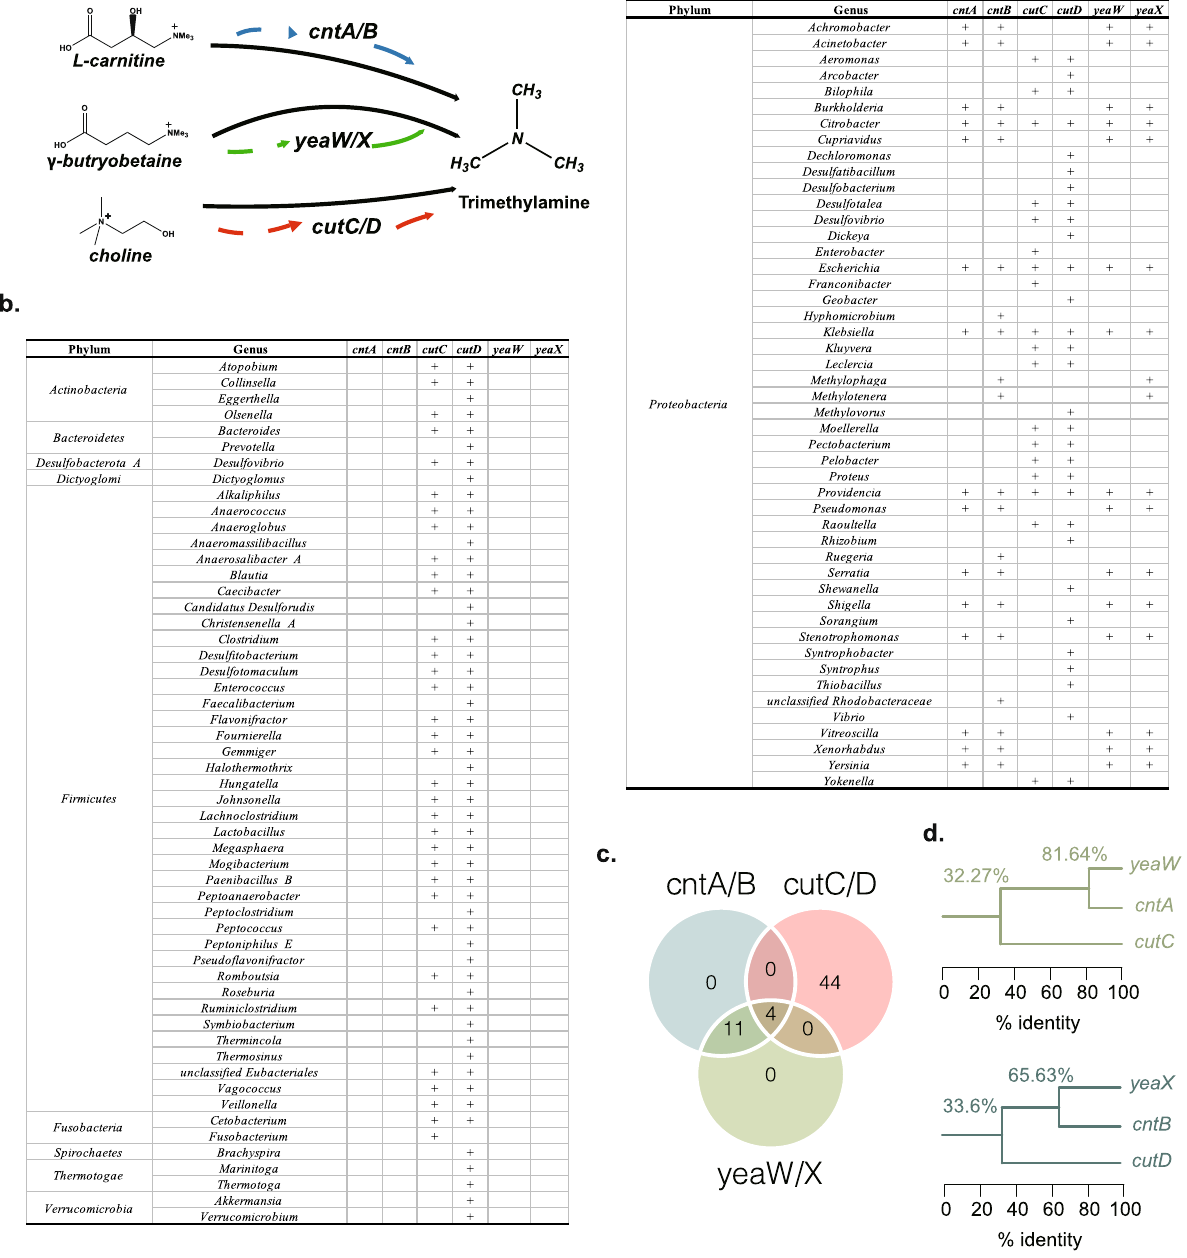
Fig. 1 Taxonomic distribution of TMA-producing bacteria. a Schematic diagram of three microbial transformation pathways of TMA-lyases, cntA/B , yeaW/X, and cutC/D . b The phyla and genera distribution of cntA/B, cutC/D, and yeaW/X . The plus signs indicate that the genus contains the genes which encoded the corresponding TMA-lyase. c Venn diagram analysis of the coexisting genera distribution of cntA/B, cutC/D, and yeaW/X . d Homology trees of three TMA-lyases and their corresponding activators. The numbers on the corner represent the average sequence identities between the TMA-lyases connected by the branch. TMA: